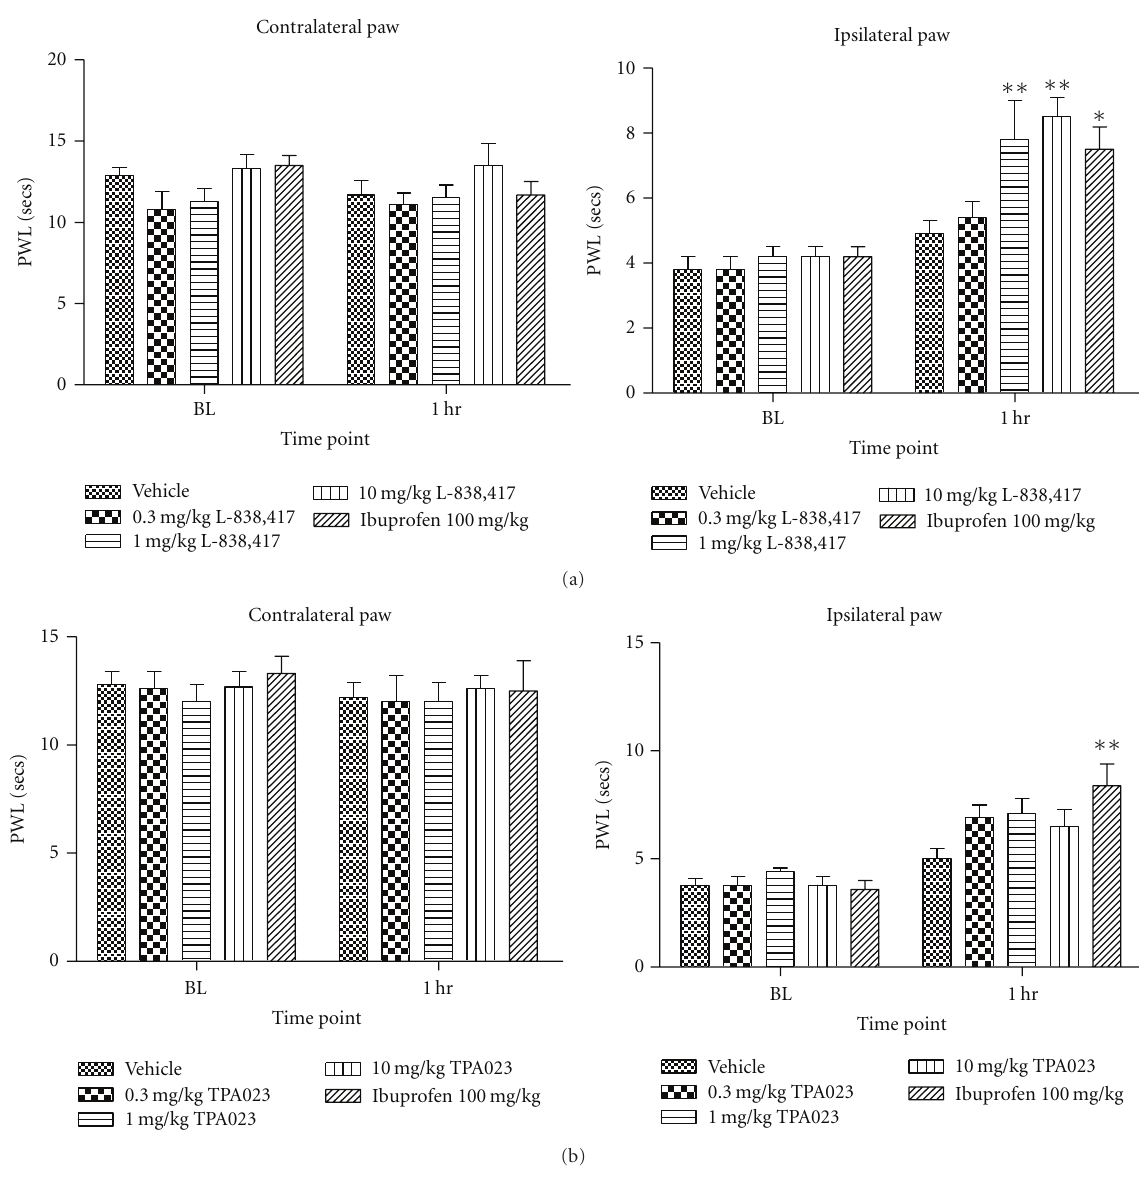
Figure 2: The e ff ects of (a) L-838,417 and (b) TPA023 on complete Freund’s adjuvant-induced thermal hyperalgesia in the rat. Data are means ± sem. n = 7-8. Data are expressed as paw withdrawal latency (PWL). BL: baseline. ( ∗ = P < 0 . 05, ∗∗ = P < 0 . 01, ANOVA compared to vehicle-treated